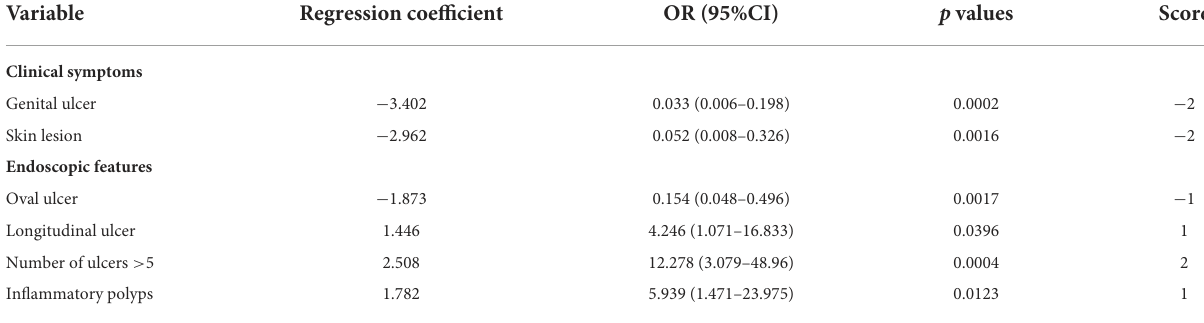
TABLE 7 The multivariate logistic regression analysis and scores of model